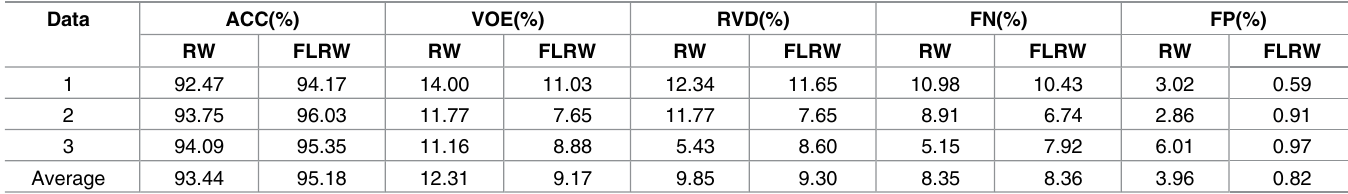
Table 1. Evaluation of